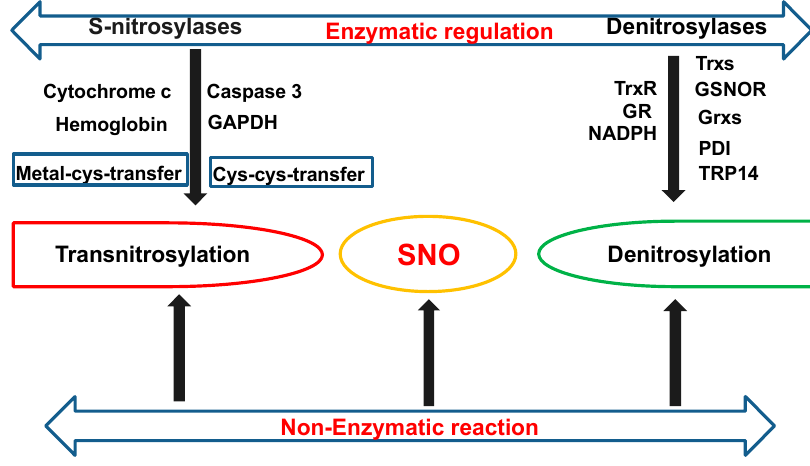
Figure 1. The scheme of main enzymatic regulations on S-nitrosothiol (SNO) homeostasis. The cellular homeostasis of SNO is regulated by two main mechanisms, transnitrosylation and denitrosylation, through nonenzymatic and enzymatic reactions. The enzymatic reactions are mediated by S-nitrosylases and S-denitrosylases, which cooperatively control steady-state cellular levels of SNOs. Enzymatic SNO formation can be achieved via a Metal-to-Cys transfer by metalloproteins, such as hemoglobin and cytochrome c, or via Cys-to-Cys transnitrosylase such as SNO-caspase 3 and SNO- glyceraldehyde 3-phosphate dehydrogenase (GADPH). Protein denitrosylation is mainly catalyzed by three major systems, the thioredoxins (Trxs) system, the GSNOR (S-nitrosoglutathione reductase) system, and the glutaredoxin systems (Grxs). Both Trxs and Grxs belong to the Trx superfamily. A few proteins other than Trxs and Grxs from the same family have also been identified as S-denitrosylases, such as PDI (protein disulfide-isomerase) and TRP14 (a thioredoxin related protein of 14 kDa).